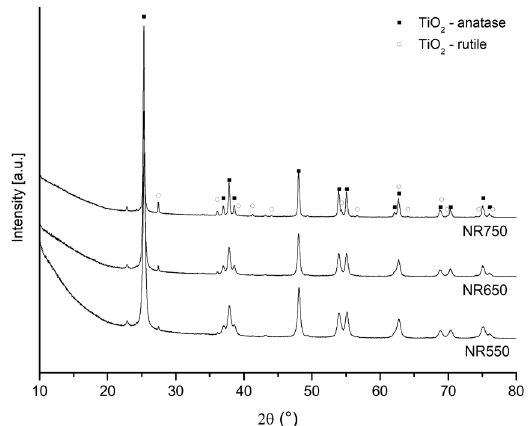
Figure 1. XRD patterns of samples NR550, NR650 and